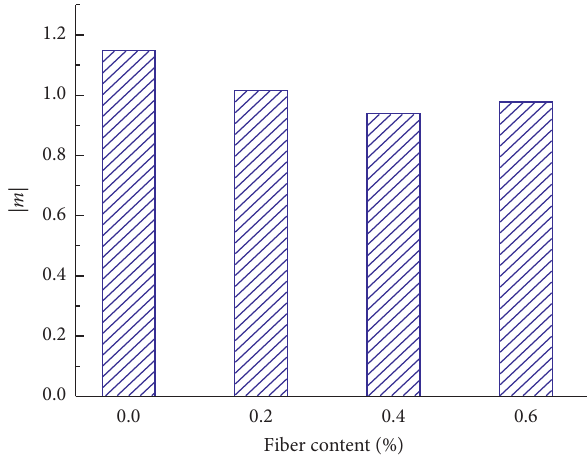
Figure 10: Slope versus fiber content.